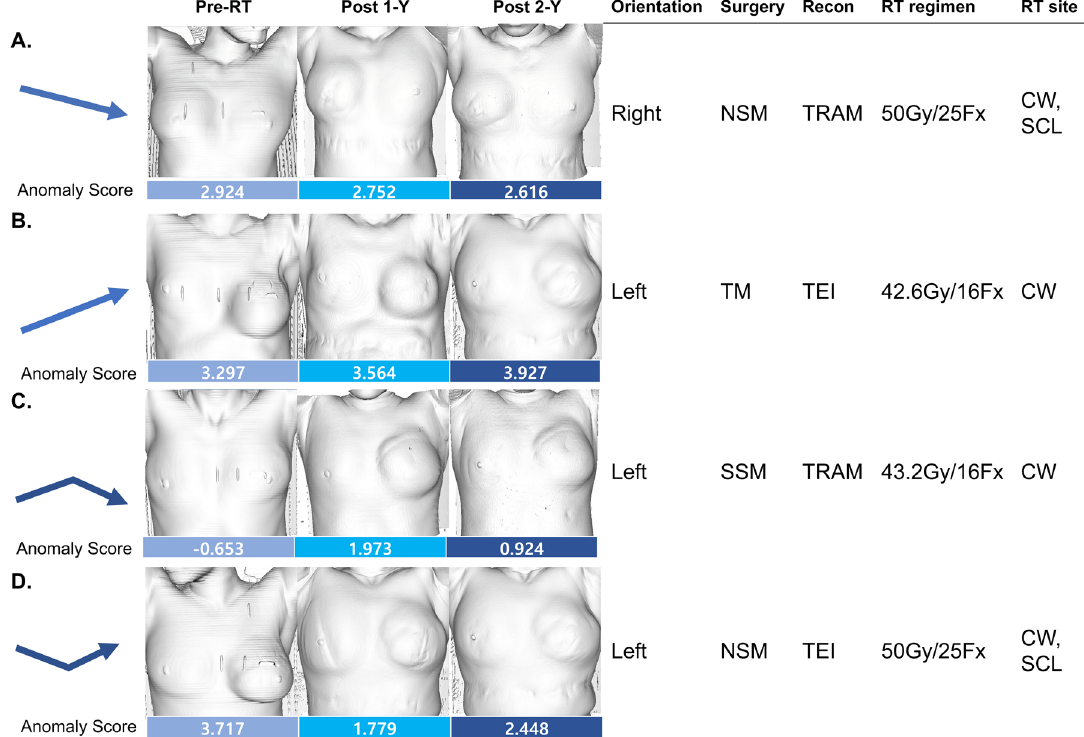
Fig. 2 The four patterns of change in anomaly score (AS) in terms of radiation therapy, according to the type of breast cancer surgery and reconstruction method. A The decreasing trend of AS in patients who received right NSM with TRAM fl ap reconstruction. B The increasing trend of AS in patients who underwent left total mastectomy followed by TEI. C The increasing-decreasing trend of AS in patients who received left SSM with TRAM fl ap reconstruction. D The decreasing-increasing trend of AS in patients who underwent NSM followed by TEI. RT radiation therapy, 1-Y 1 year, 2-Y 2 years, NSM nipple-sparing mastectomy, TEI tissue-expander insertion, TRAM transverse rectus abdominis muscle, Fx fractions, CW chest wall, SCL subclavian lymph node, SSM skin-sparing